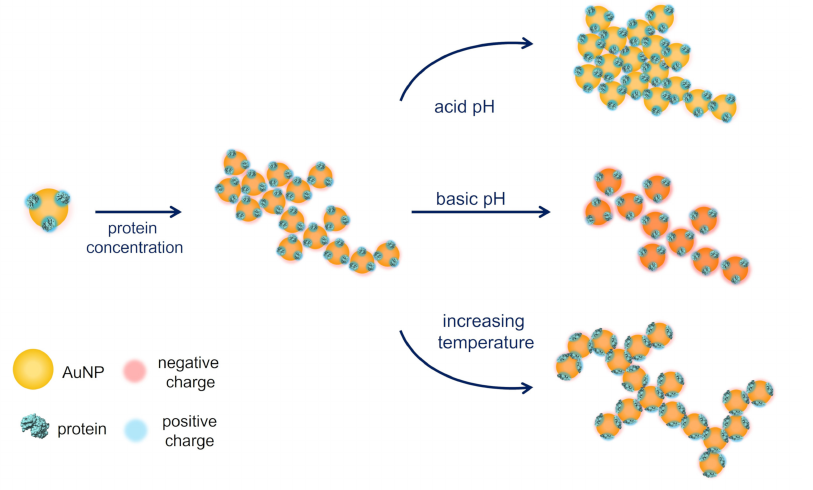
Figure 8. Schematic illustration of the observed structural variation of the protein-AuNPs assemblies in response to the different external stimuli analyzed: protein concentration, pH and